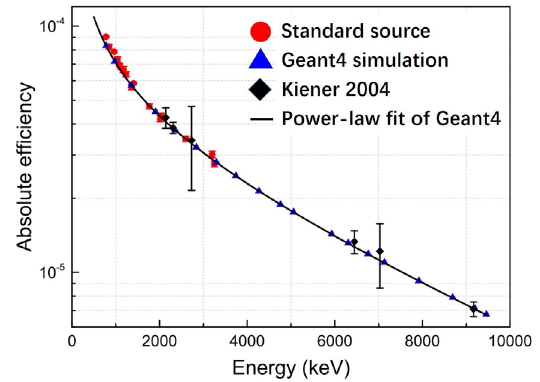
Figure 2. Sample spectrum of 13 C(p, γ ) 14 N resonance detected